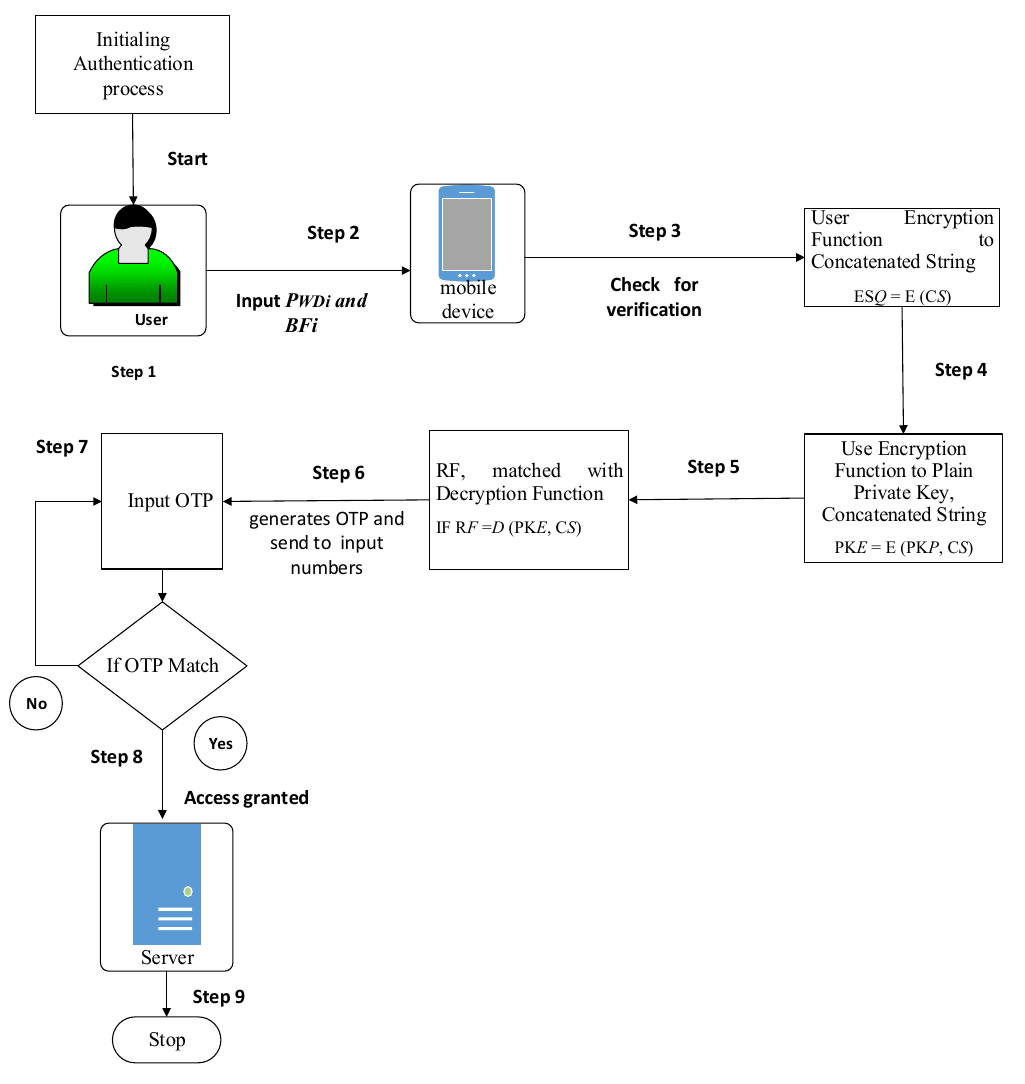
Figure 3. Authentication process